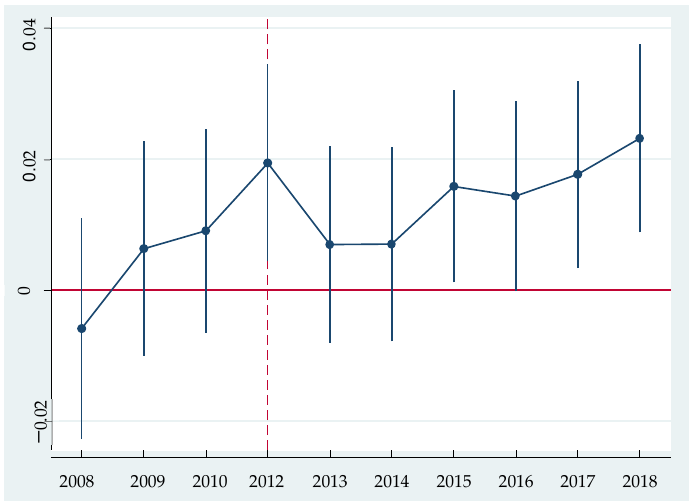
Figure 1. Parallel trend test results.